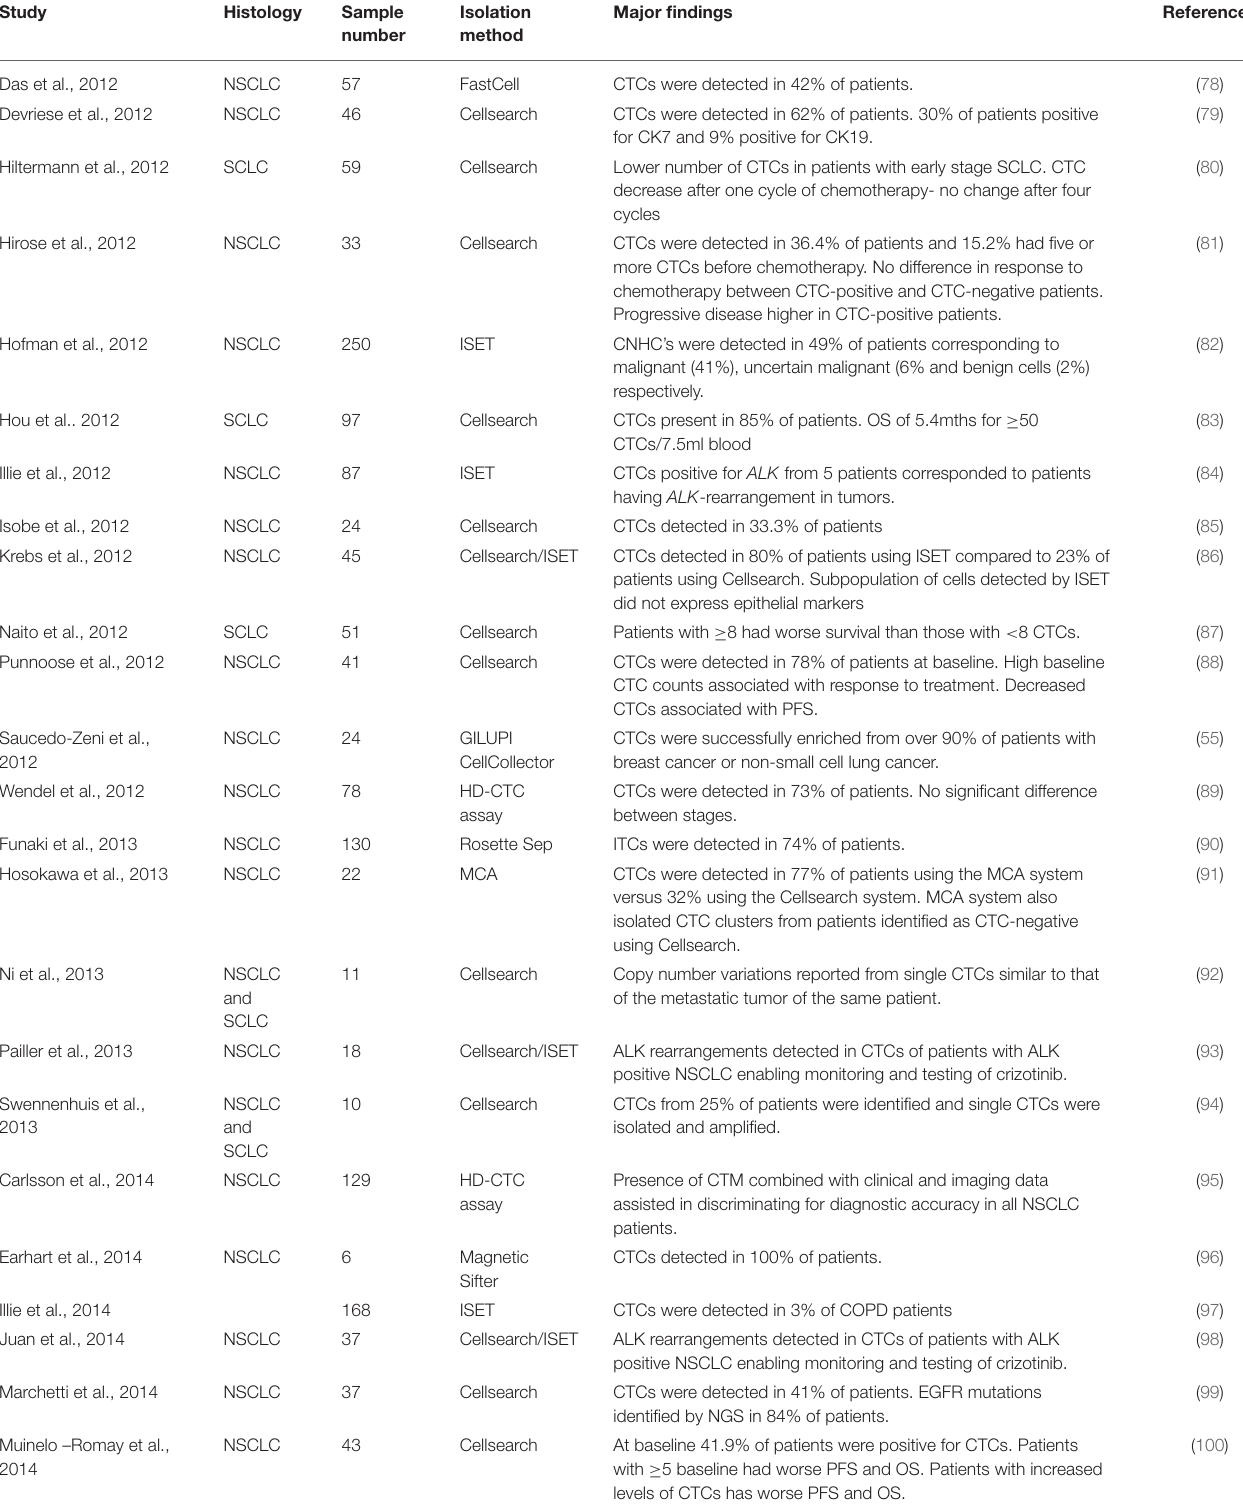
TABLE 3 | Summary of a number of Circulating Tumor Cell studies in lung